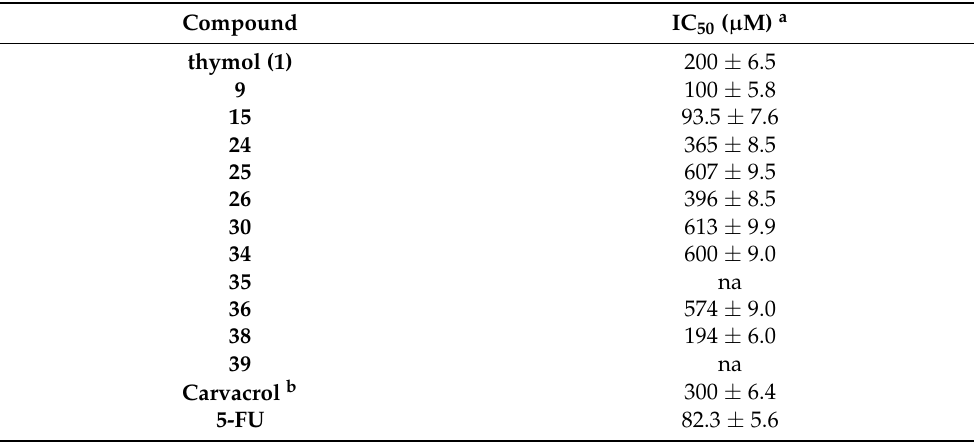
Table 2. IC 50 values of the selected and reference compounds are expressed as mean ± standard deviation (SD) of three experiments with quintuplicate